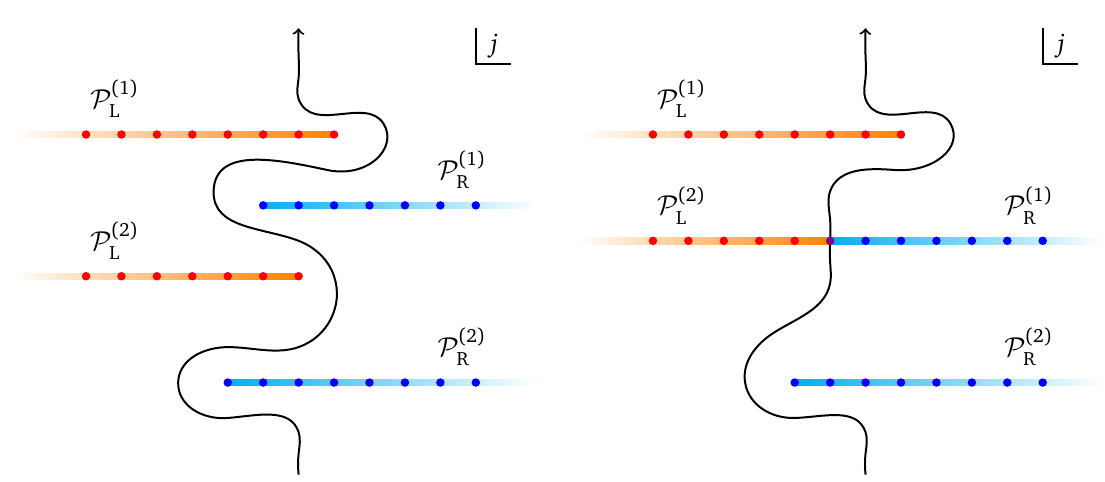
the integration contour in eq. (A.5) can i